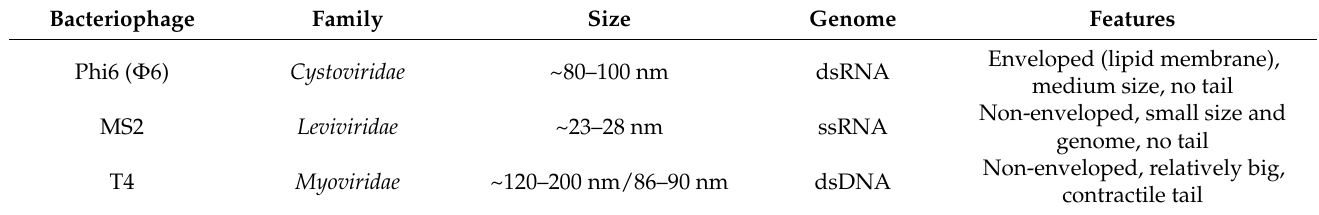
Table 1. Bacteriophage